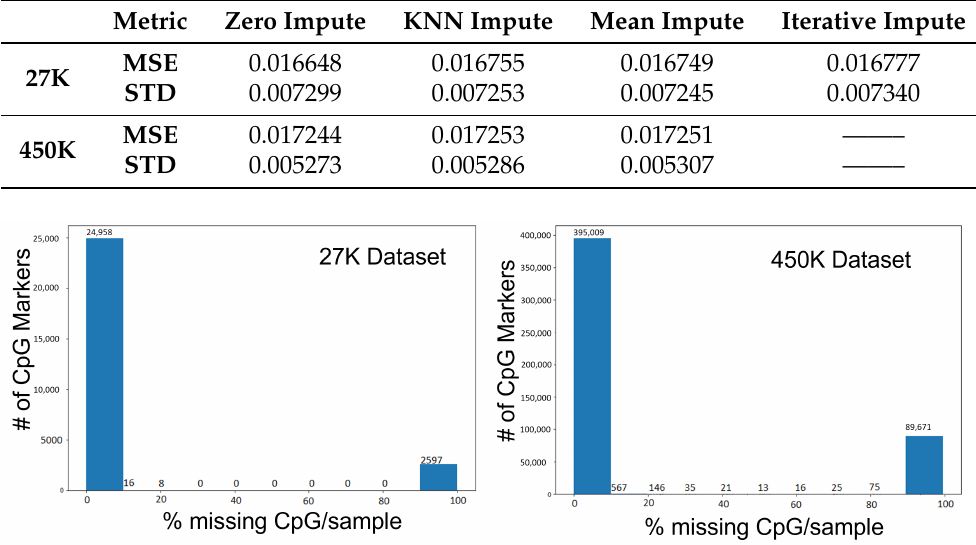
Figure 1. Missing percentage of CpG markers per sample among the 27K and 450K datasets.